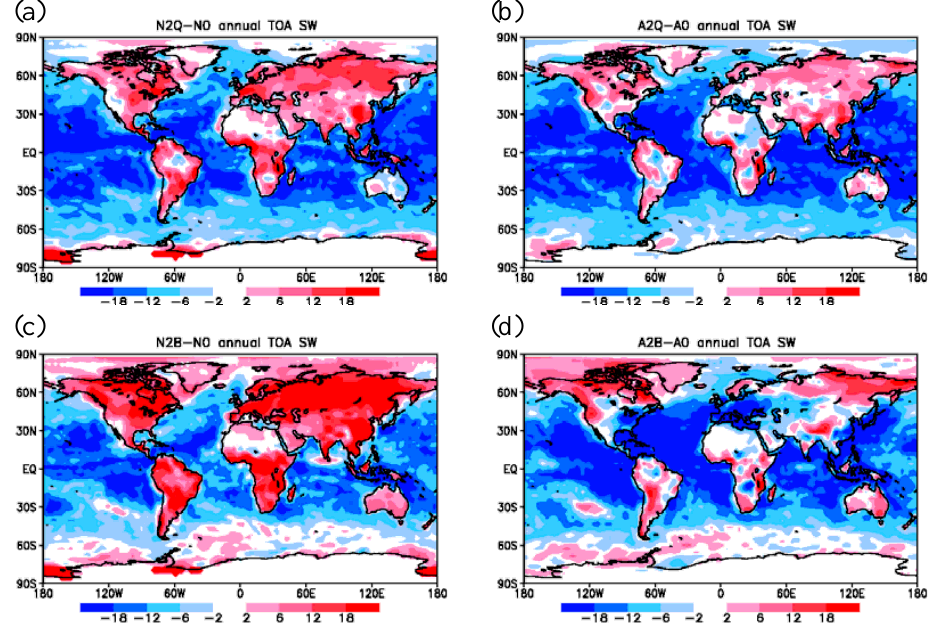
Fig. 8. Differences in all-sky shortwave radiation (in W m − 2 ) between simulations using the empirical formula (2-2) and those with specified effective radii. (a) N2-N0, (b) A2-A0, (c) N2B-N0, and (d) A2B-A0. A2 and N2 applied the coefficients from Quass and Boucher (2005), whereas A2B and B2B applied those from Boucher and Lohmann